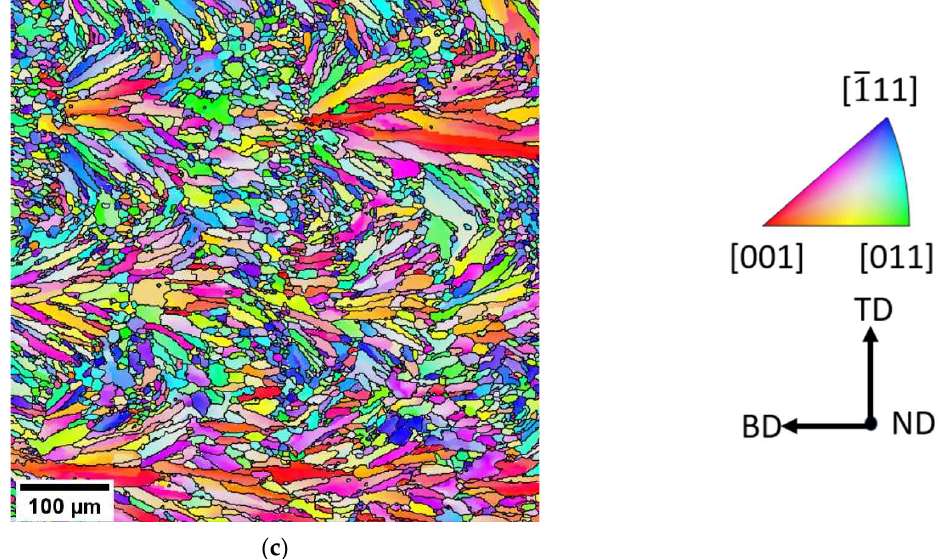
Figure 2. EBSD inverse pole figure (IPF) maps along x-direction (IPF-X), i.e., along BD of PBF-LB/M AlSi10Mg: ( a ) AB, ( b ) HT1, and ( c ) HT2 conditions.